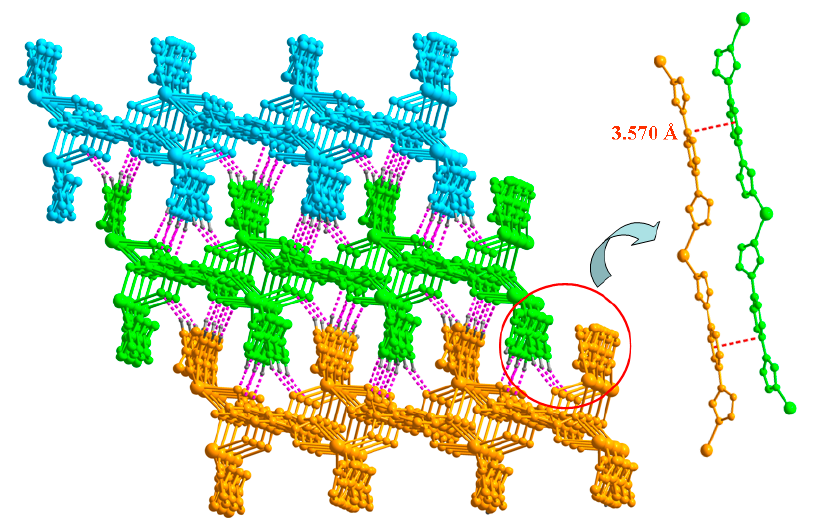
Figure 5. 3D structure of 1 extended by weak hydrogen bonding and π - π stacking interactions. Table 2. Selected bond lengths (Å) and bond angles ( ° ) for 1 .